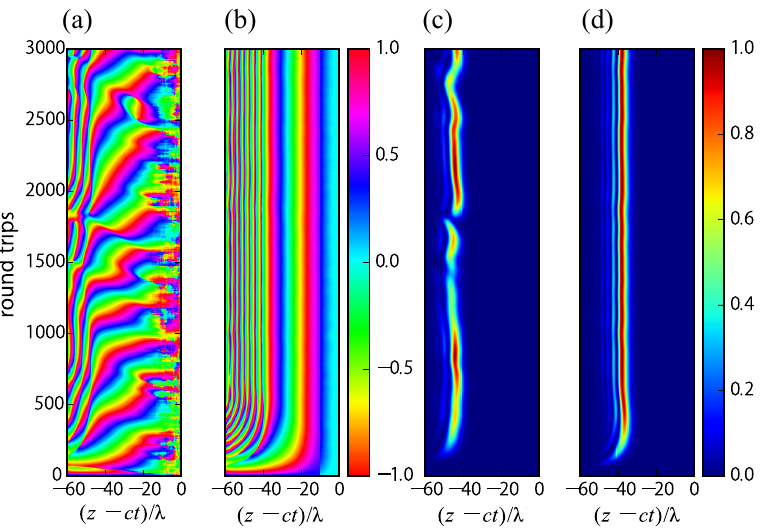
Figure 12. Contour plots of instantaneous phase of simulated FEL pulses in units of π rad for: ( a ) without injection seeding; and ( b ) with injection seeding. Contour plots of instantaneous intensity of FEL pulses normalized to the maximum intensity for: ( c ) without injection seeding; and ( d ) with injection seeding